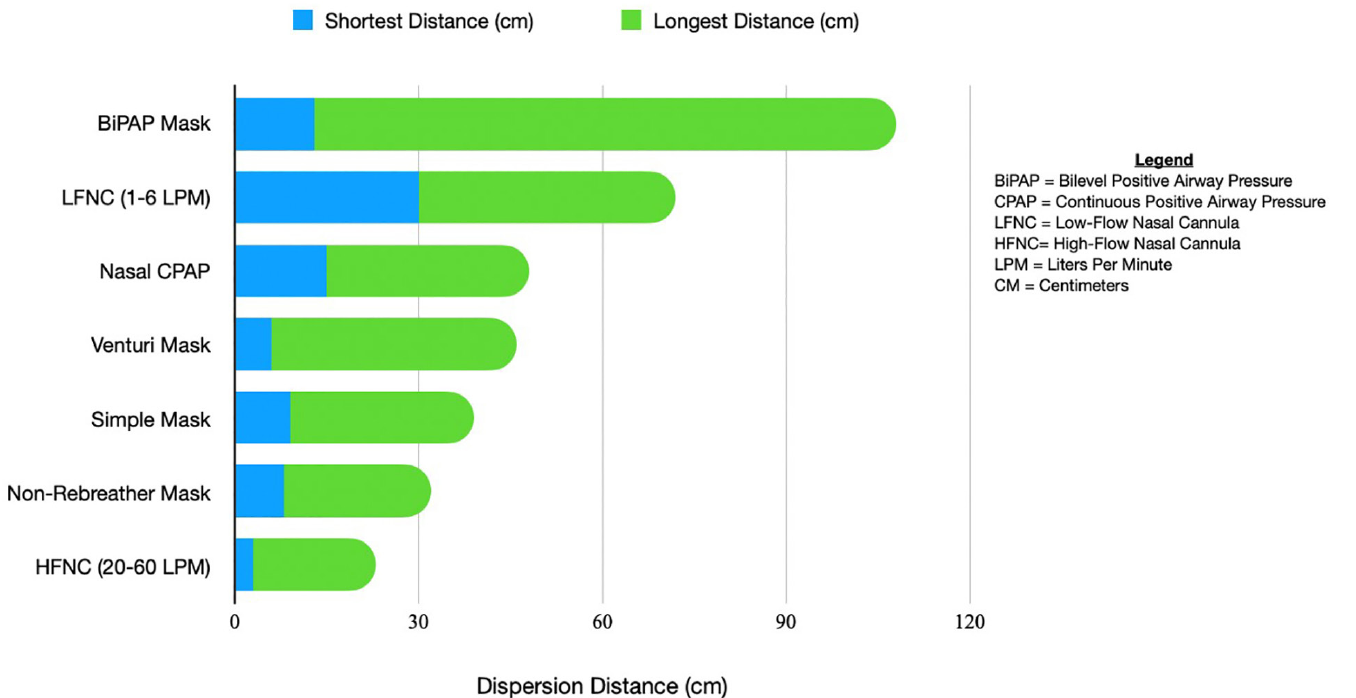
Figure 2. Oxygen modality dispersion distances. (Li et al; Whittle et al; Hui et